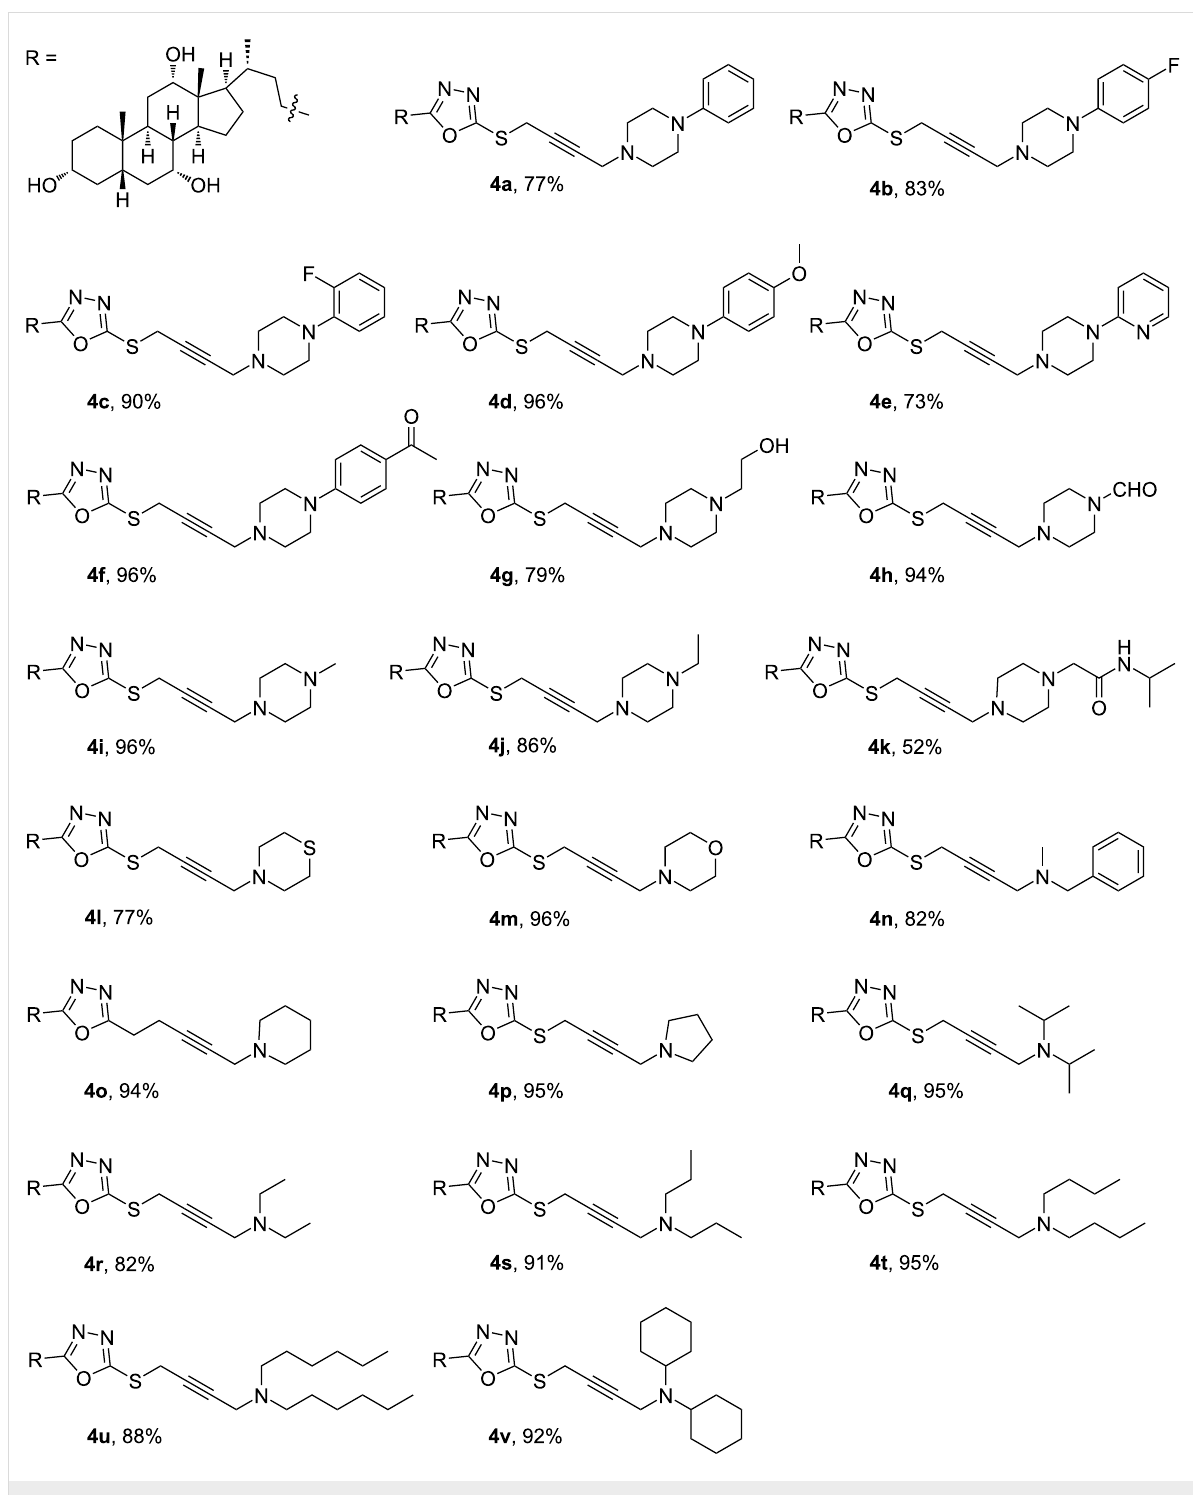
Figure 2: Structures of target compounds 4a – v .